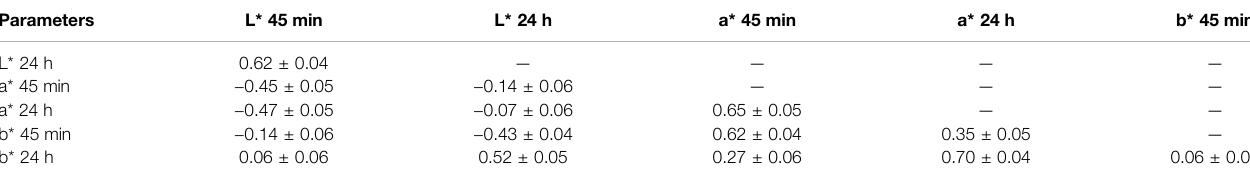
TABLE 3 | Genetic correlation ±standard error between meat color.